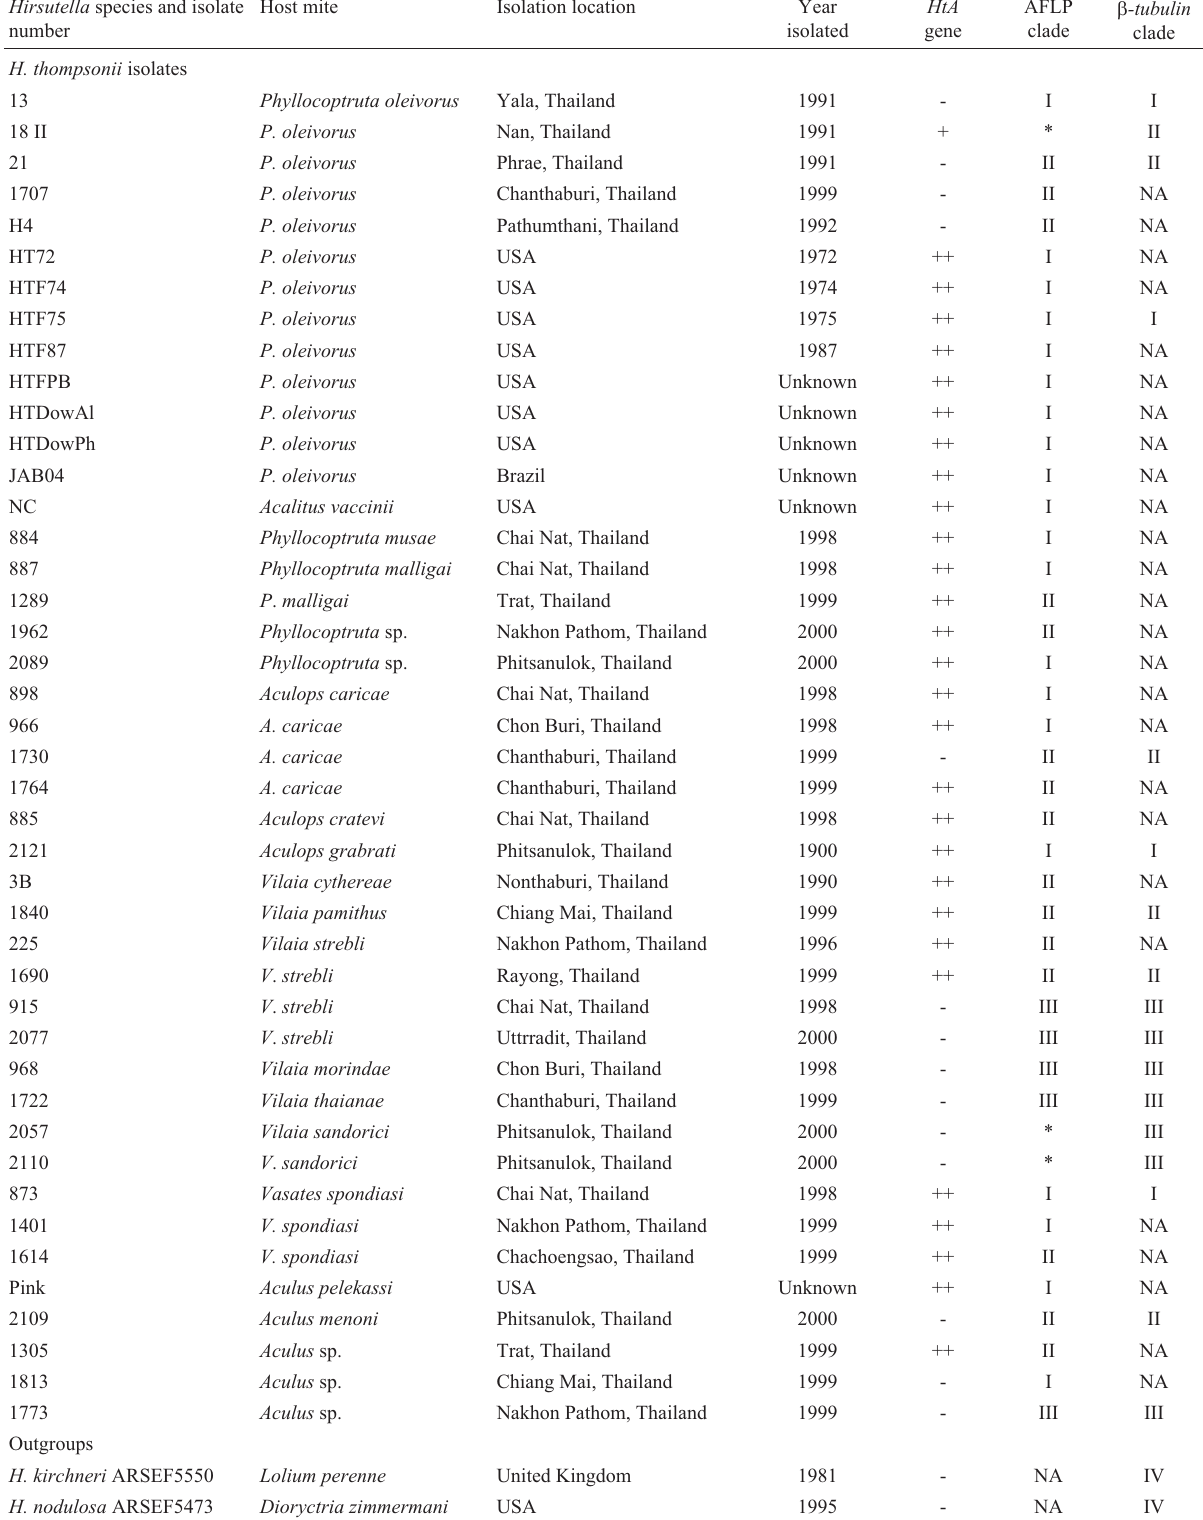
Table 1 - Data on the Hirsutella isolates examined in this study. The HtA gene was detected using the PCR reaction (- no band; + weak band; ++,normal band) and the AFLP and (cid:2) -tubulin clades (I, II, III and IV) were constructed by maximum parsimony tree analysis of AFLP and partial (cid:2) -tubulin gene sequence data (NA = not analyzed and an asterisk (*) represents the isolates standed separated from the